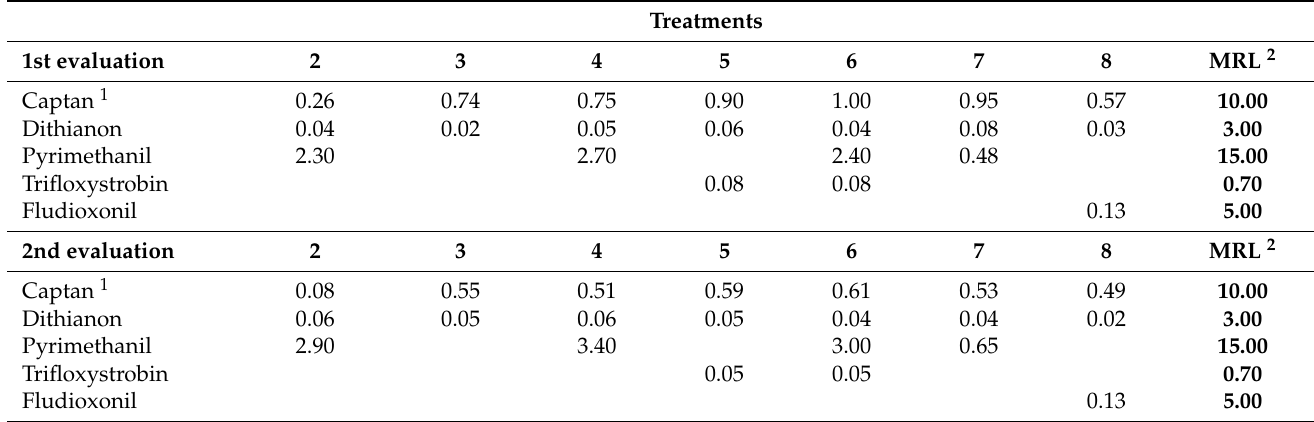
Table 4. Fungicide residues [mg/kg] after harvest (1st evaluation) and after 5 months of storage (2nd evaluation).